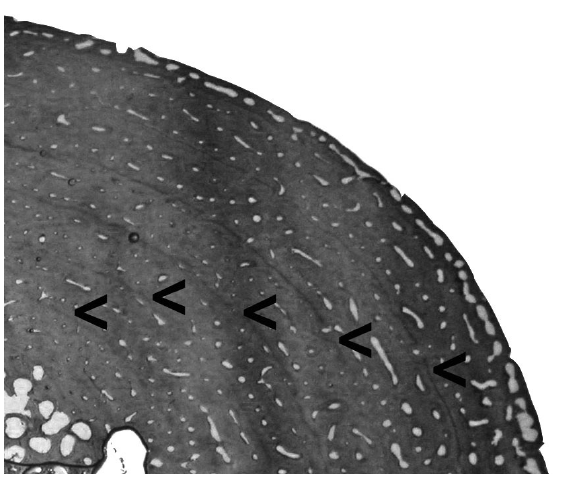
Fig . 1. – Image of bone section. Arrows show the lines of arrested growth